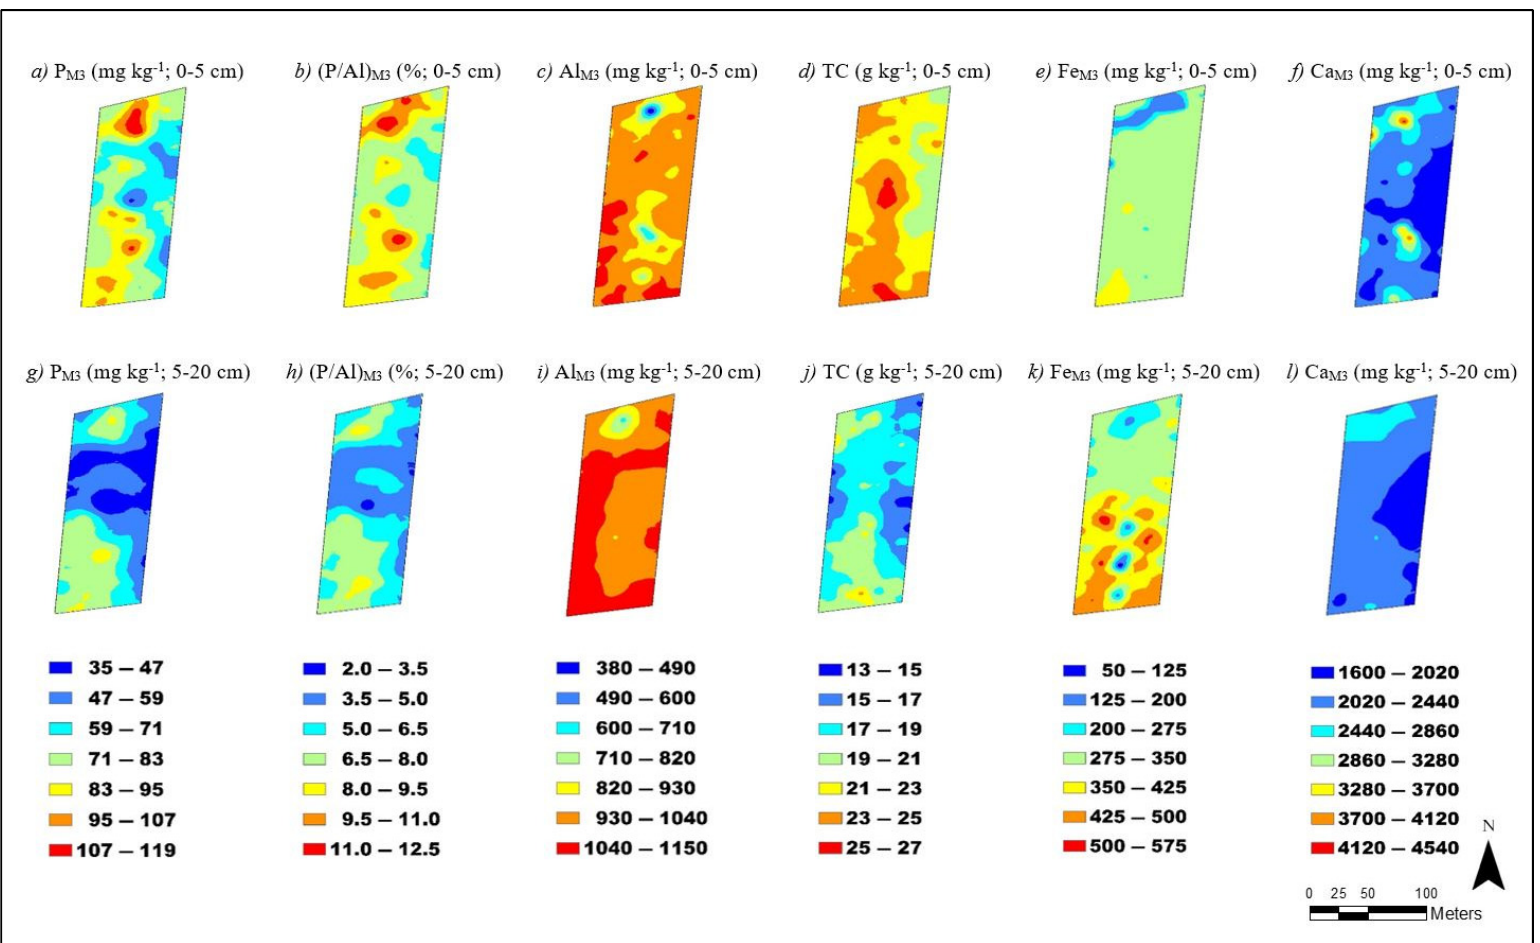
Figure 4. Spatial distribution maps of P M3 ( a , g ), (P/Al) M3 ( b , h ), Al M3 ( c , i ), TC ( d , j ), Fe M3 ( e , k ) and Ca M3 ( f , l ) for the 0–5 cm and 5–20 cm soil layers in the no-tillage field.